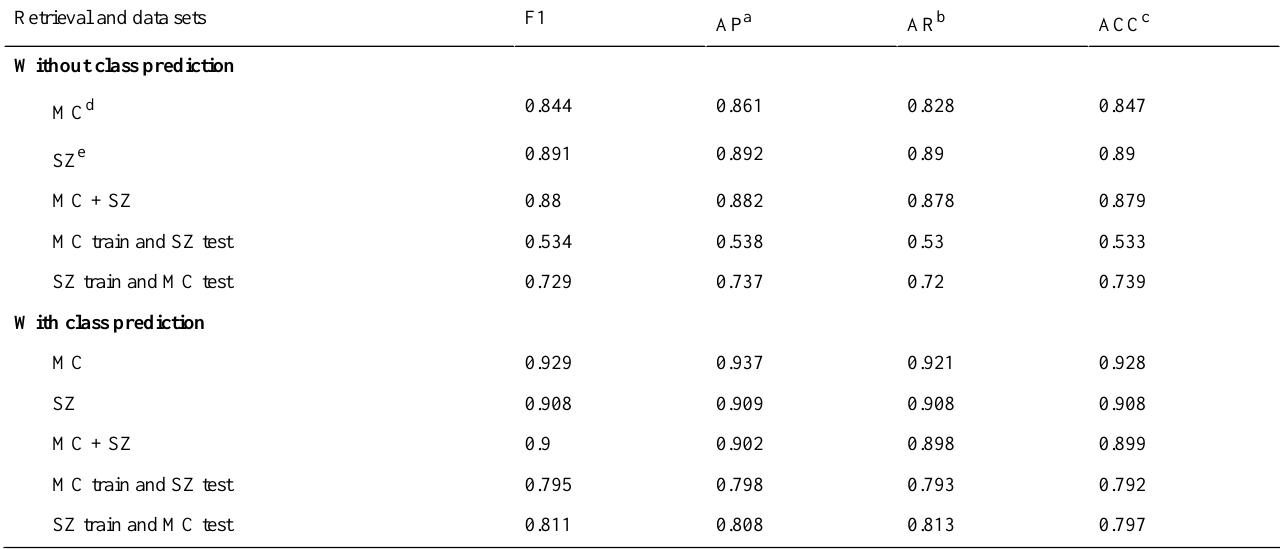
Table 4. Comparative retrieval performance with and without predicting the class label